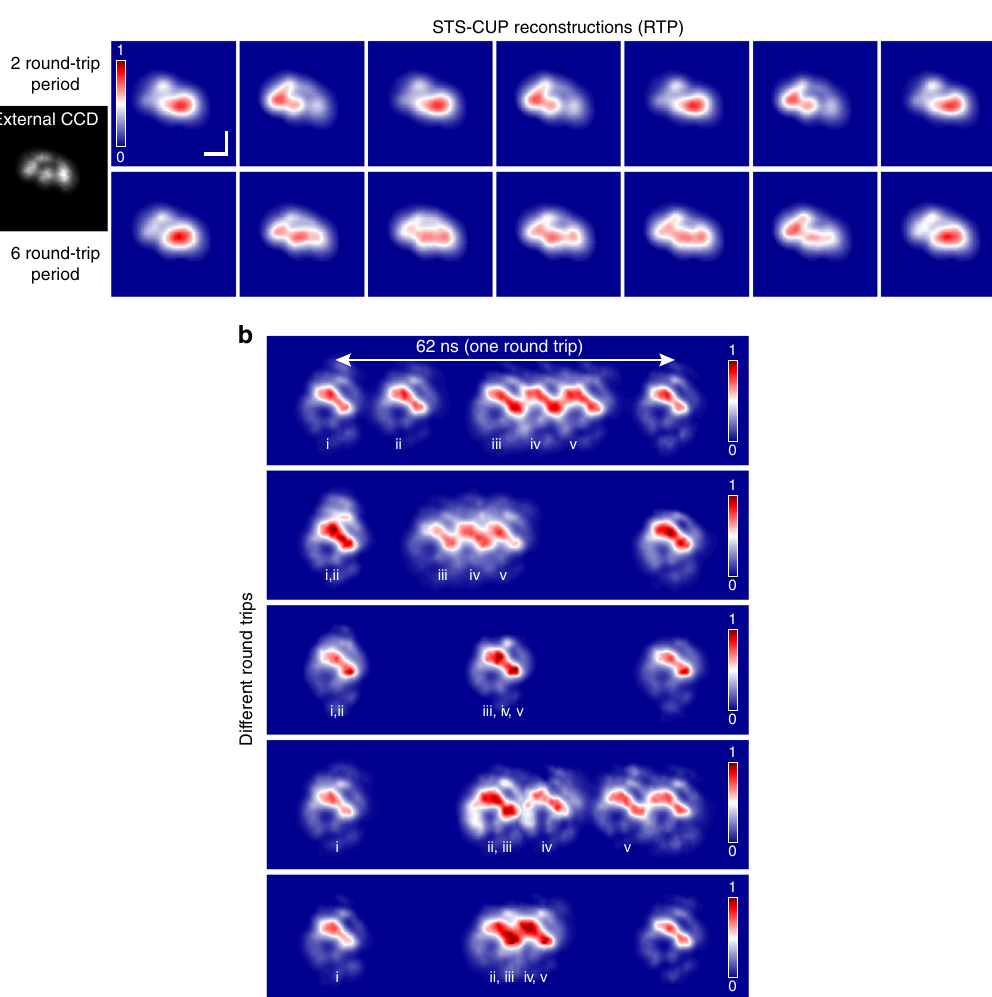
Fig. 4 Stochastic laser dynamics of a spatio-temporal mode-locking laser. a Round-trip spatial pro fi les of successive 3D DSs with different evolution periods, i.e., two (top) and six (bottom) in this case, see Supplementary Movies 3 and 4. The left gray image shows the integrated spatial pro fi le measured by an external CCD. Scale bar is 400 µ m. b Temporal variation of multi-pulse solitons within the same round trip. Four addition solitons (ii – v) were generated as a result of increasing pump power. Attraction and repulsion of the solitons within the round-trip period was observed. Note that the laser cavity was not altered during the